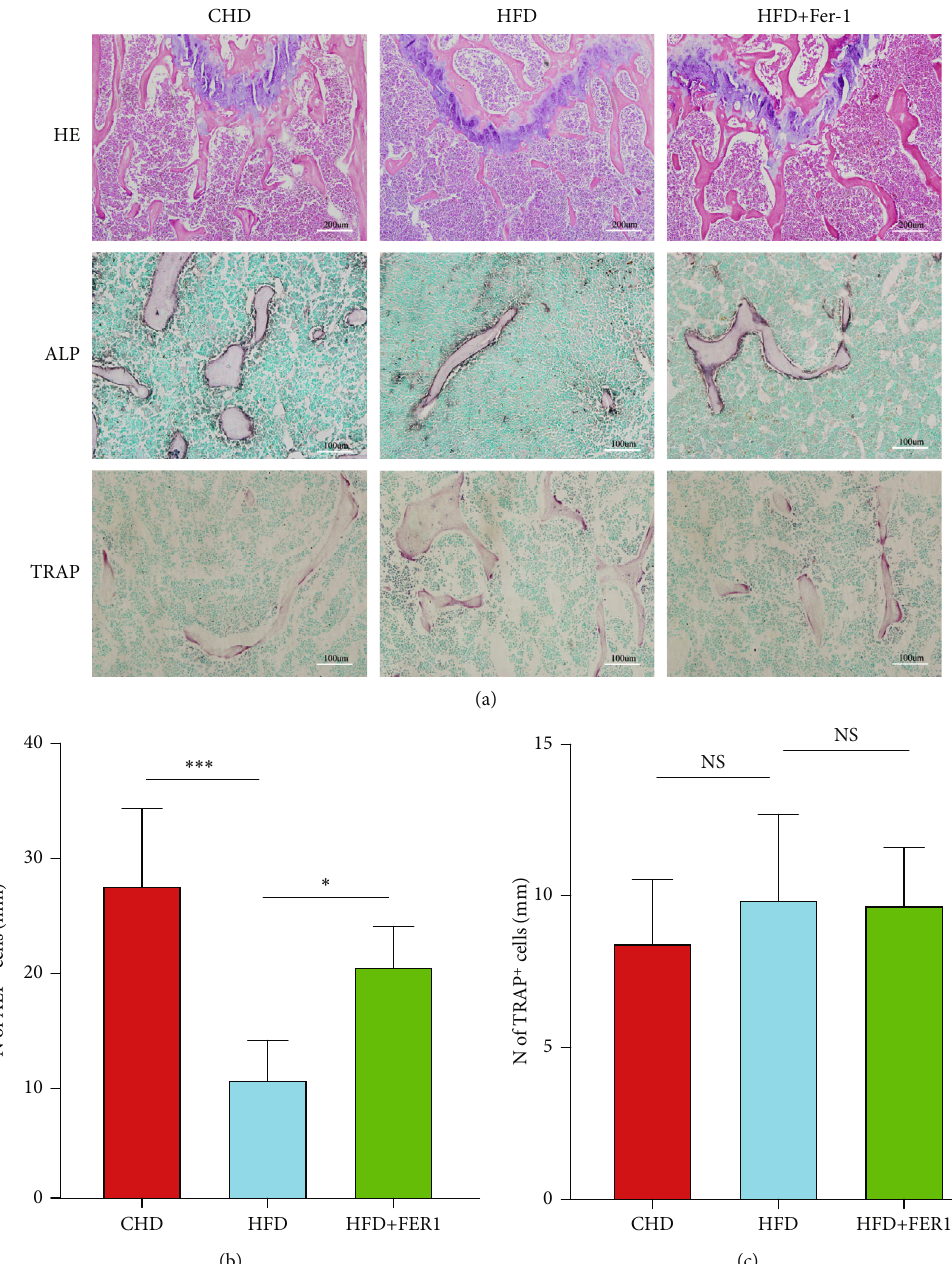
Figure 2: Chemical staining of mouse femurs with hematoxylin and eosin (H&E) after 12 weeks of feeding mice on normal and high-fat diets revealed a signi fi cant reduction in the number of metaphyseal trabeculae in the femur, which was then restored to some extent after administration of ferroptosis inhibitors (a); scale bar represents 200 μ m. Experiments revealed that after mice consumed a diet high in fat content, the number of alkaline phosphatase- (ALP-) positive osteoblasts on the surface of the trabeculae in the femur was signi fi cantly reduced (b), and the reduction in the number of osteoblasts was somewhat mitigated by a high-fat diet accompanied by treatment with ferroptosis inhibitors in mice. Osteoblasts are shown in brown and nuclei in green. Quanti fi cation of the number of osteoblasts per bone surface (b). Scale bars represent 100 μ m, n = 5/group , ∗ P < 0 : 05 , ∗∗∗ P < 0 : 001 . Quanti fi cation of staining for TRAP+ cells in the femoral bone marrow cavity (a, c), with osteoclasts in red and nuclei in green (a) and NS indicating no statistical di ff erence in component; scale bars represent 100 μ m, n = 5/groups